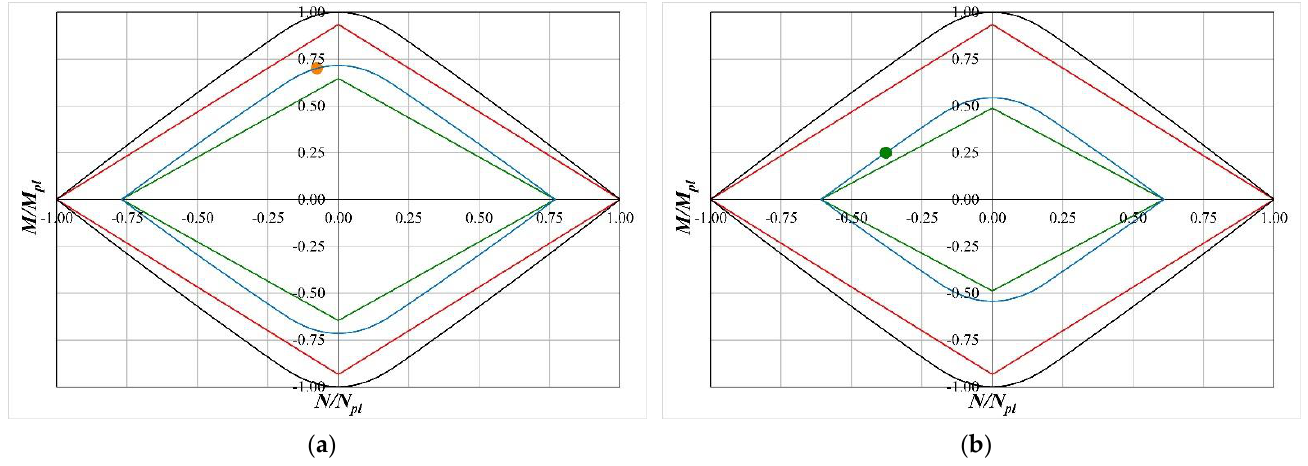
Figure 13. Dimensionless domains: HEA300 elastic (red line); HEA300 yield (black line); LRPD elastic (green line); LRPD yield (blue line). ( a ) design point 1; ( b ) design point